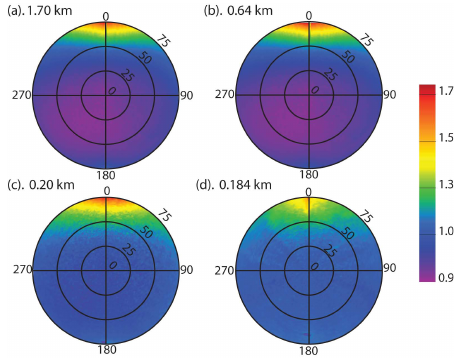
Fig. 3. Snow BRF in CAR red band derived for the 7 April 2008 measurements at three different flight altitudes, and on 15 April at one elevation (d)